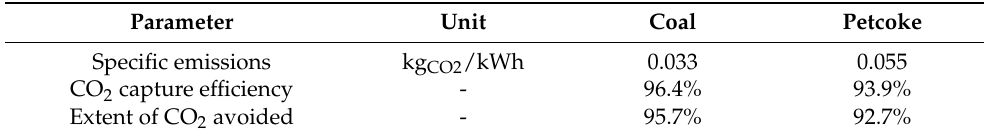
Table 7. CO 2 capture and CO 2 avoided efficiency.